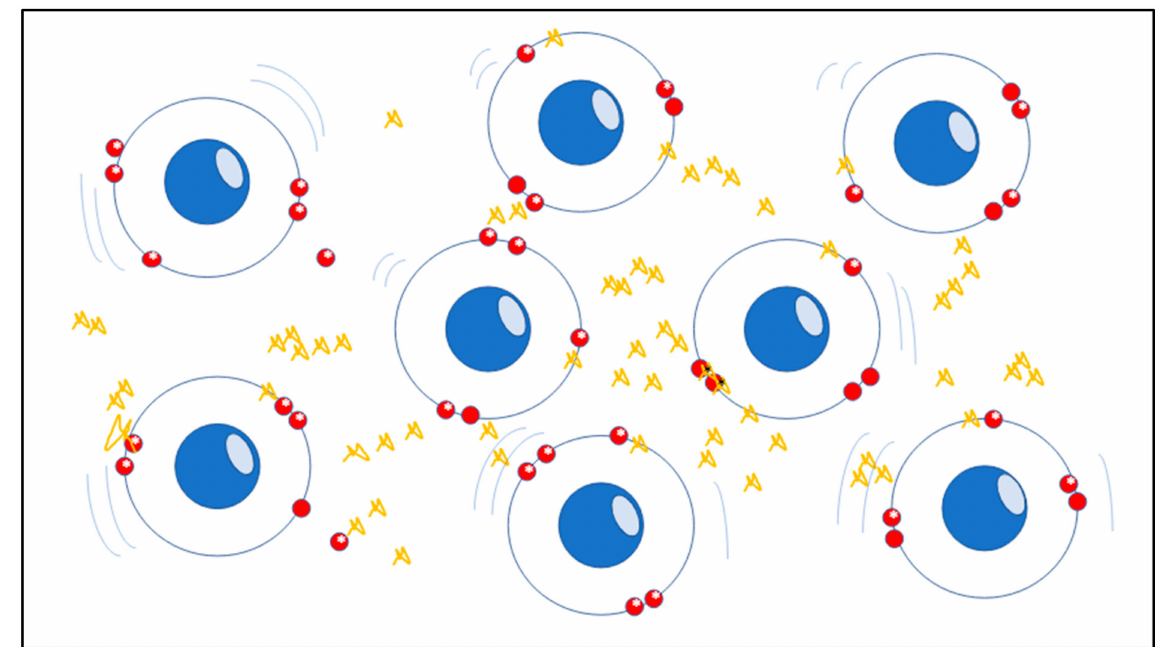
Figure 1. The picture represents the unstable atomic compound of mitochondria, the structure of the matter is indicated by the precise order of electrons and nuclei in atoms and molecules and is based on electron spin as a crucial moment which has physical significance in chemistry. When atoms tend to lose electrons, the red spheres, they start being negatively charged becoming unstable as ROS (Gargiulo Isacco Ciro and Nguyen CD